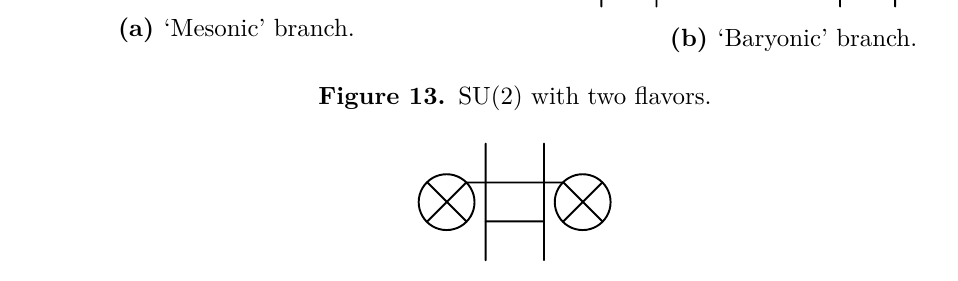
Figure 14. Mirror dual of SU(2) with two